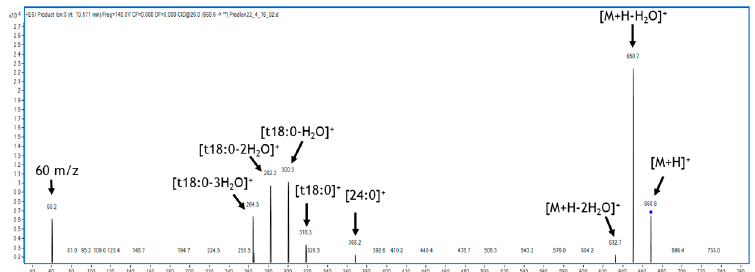
Figure 4. Example of fragmentation pattern for a sphingolipid. The phytoceramide with m/z 667.6 (t18:0) showed a clear fragmentation pattern with the 60 m/z fragments typical of sphingoid